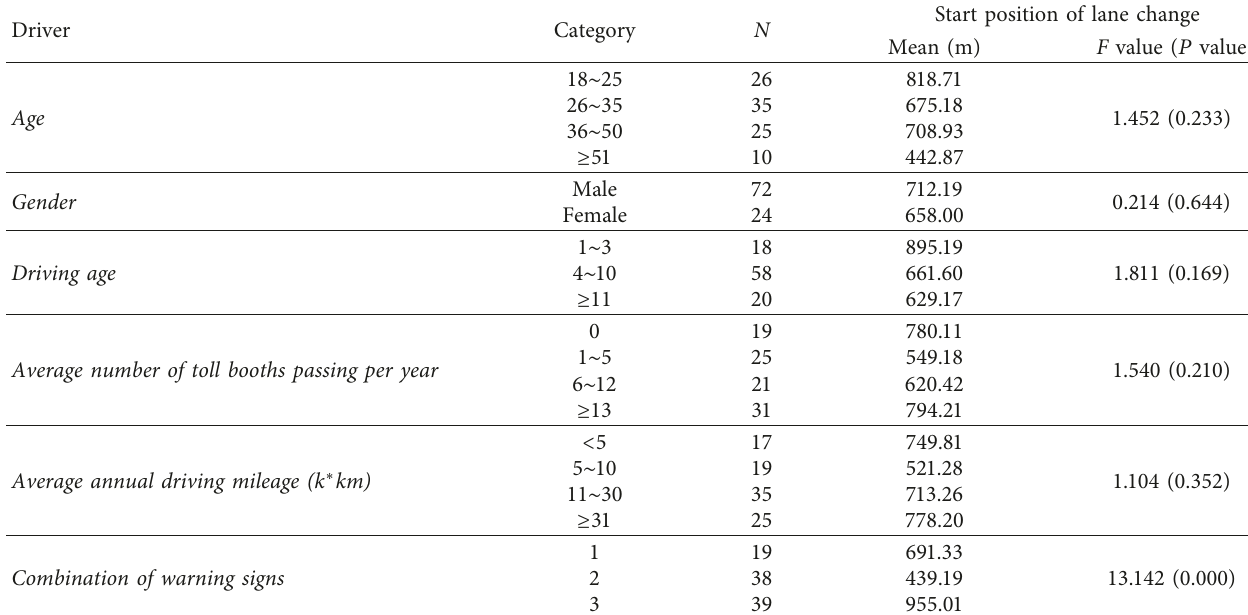
Table 4: Results of descriptive statistical analysis of start position of lane change and analysis of variance test.